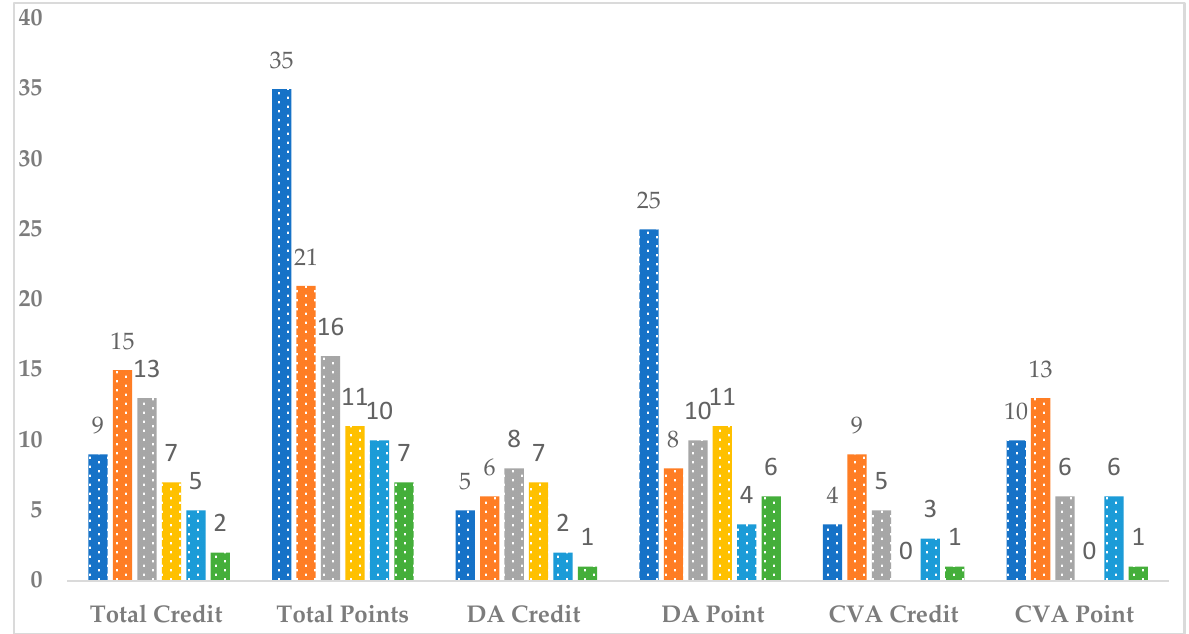
Figure 4. BIM Application in the GBI Process .